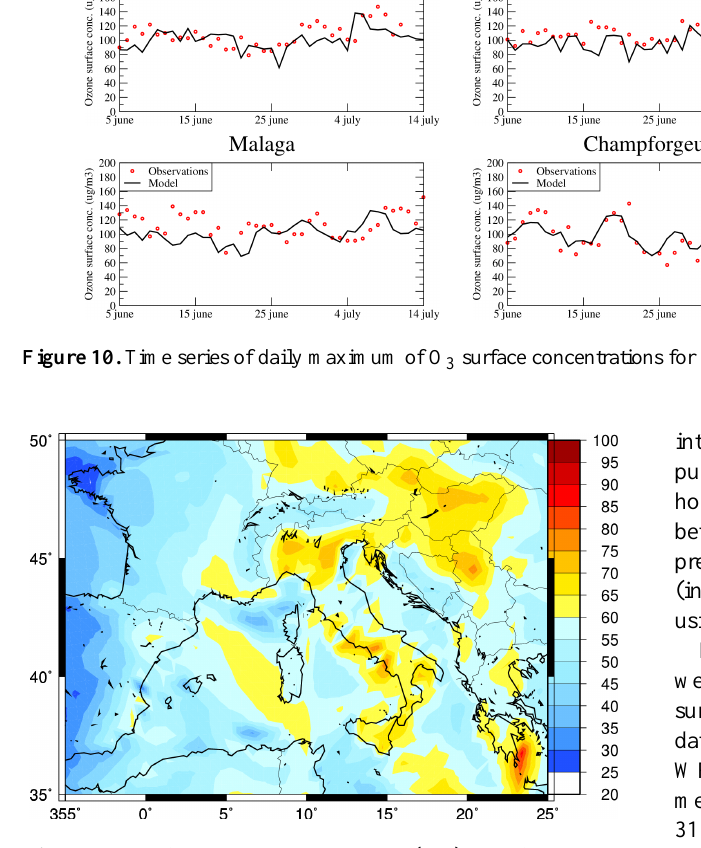
Figure 11. Surface ozone concentrations (ppb) map for 17 June 2013,